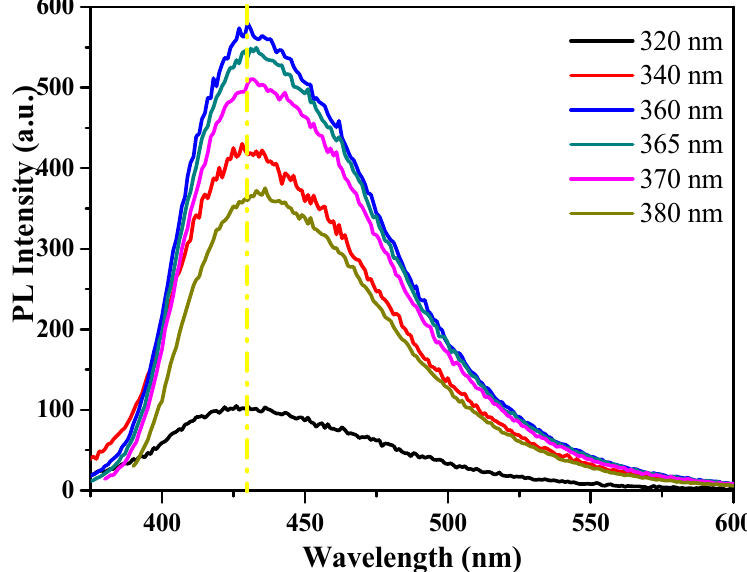
Figure 1. Photoluminescence spectroscopy of graphene quantum dots excited by the light of different wavelengths.